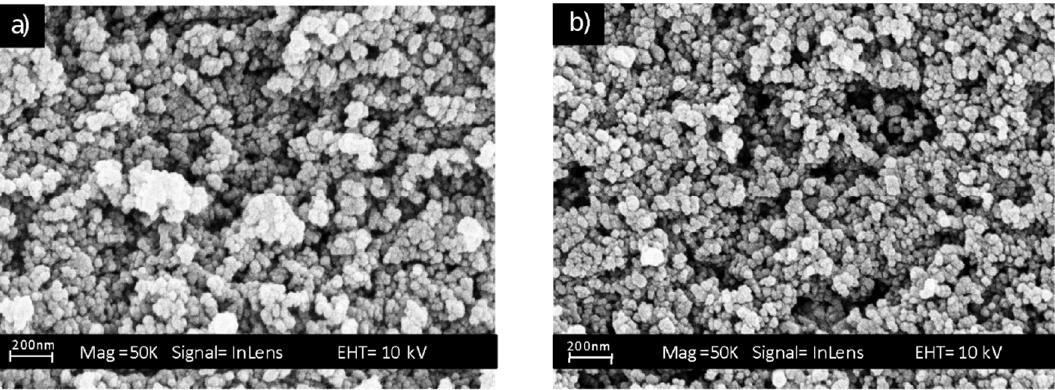
Figure 3. Scanning electron micrograph of surface morphologies for the ( a ) TP0 and ( b ) TP2 samples. EHT, extra high tension.